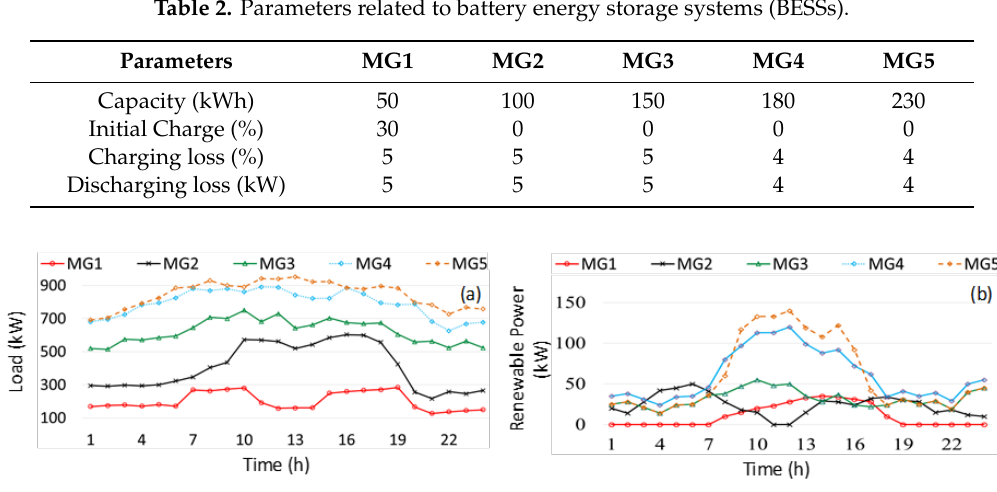
Figure 6. Microgrid-wise forecasted values of: ( a ) load; ( b ) renewable generation.